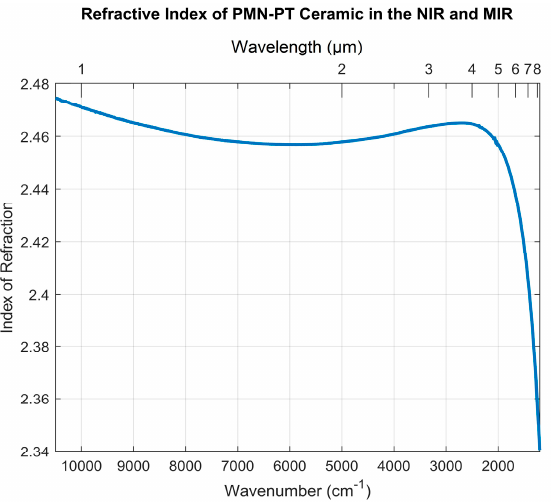
Figure 16. The calculated dispersion curve for the PMN-PT sample after combining the data from the NIR and MIR transmission spectra.